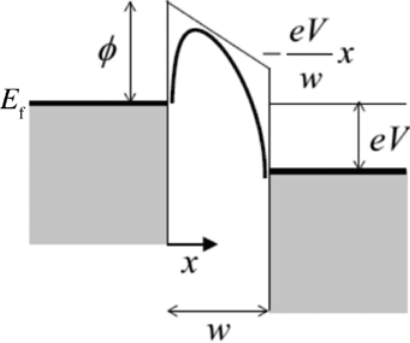
Figure 2: Potential barrier with height φ across an insulating layer width of w sandwiched between two metallic films. Electrons in the conduction band under Fermi level E for each metallic electrode f can tunnel through the barrier. Applied bias V by the incoming terahertz field distorts the barrier profile asymmetrically, thereby the current flowing from left to right. The figure is reproduced from Reference